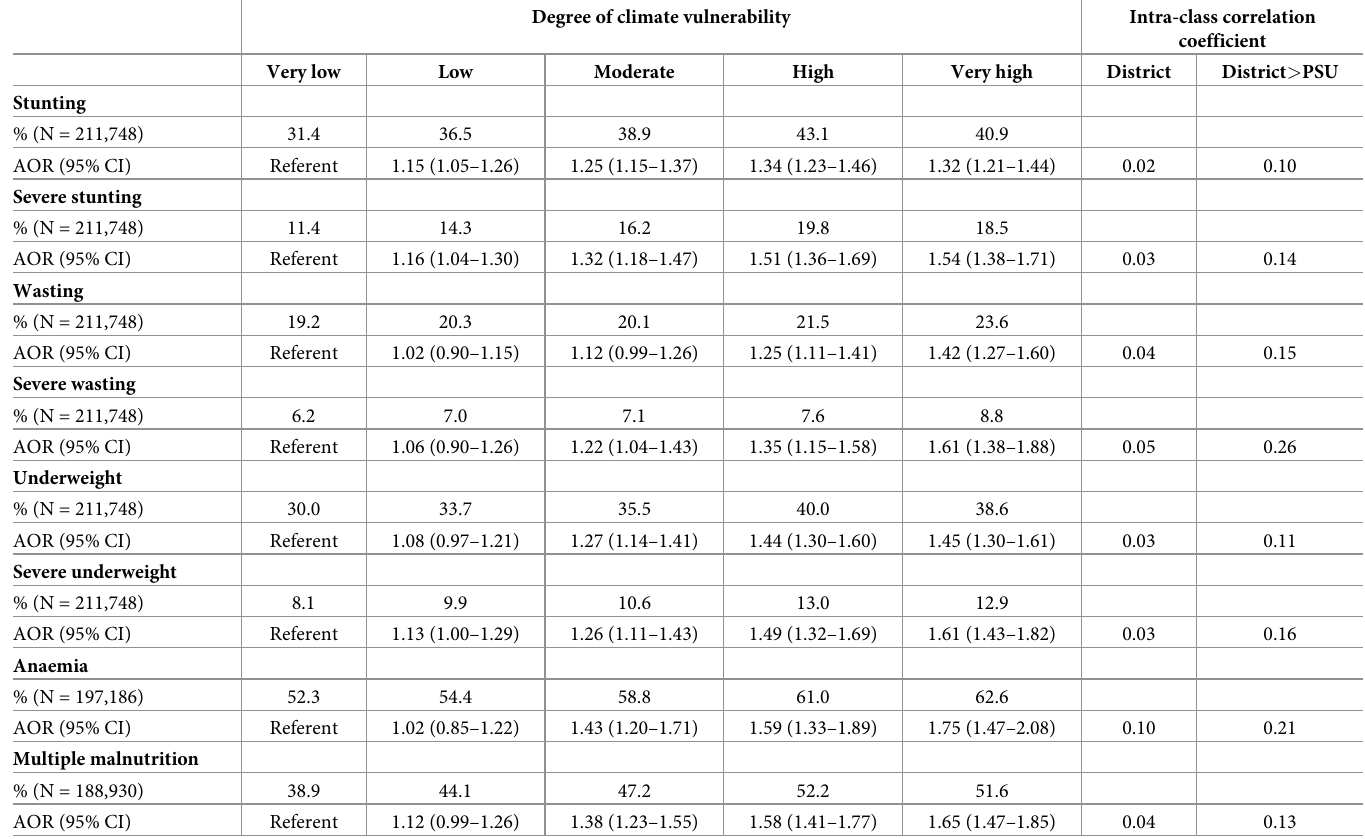
Table 2. Unadjusted percentage and adjusted odds ratio predicting the nutritional status of children by the degree of climate vulnerability,